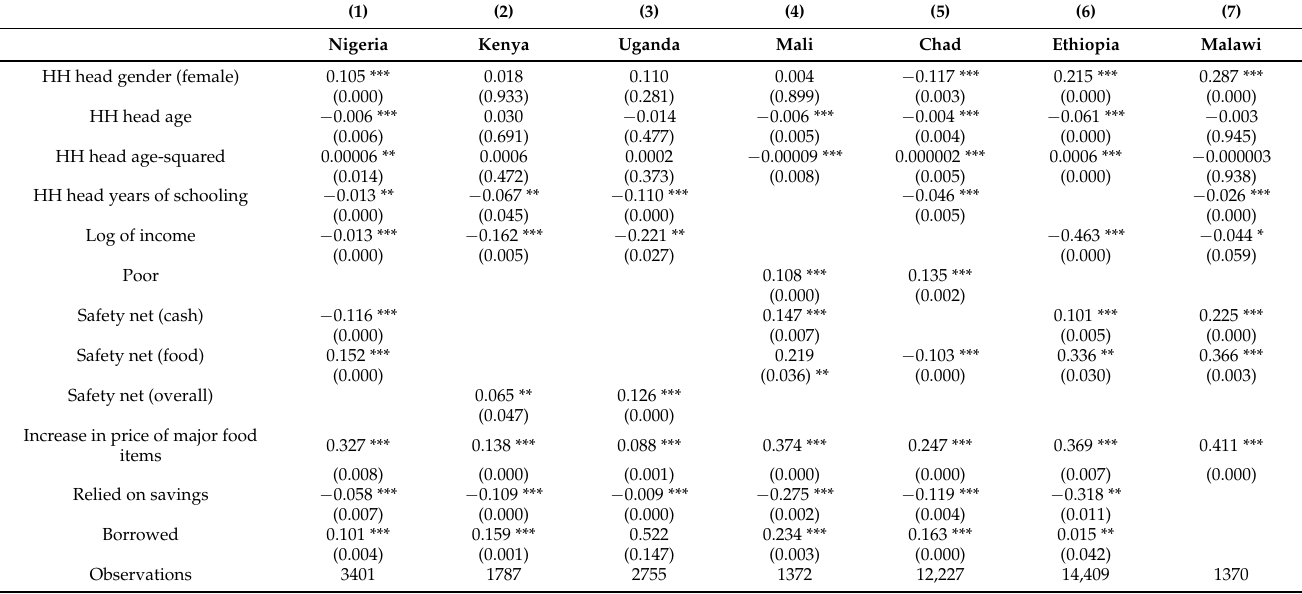
Table A2. Determinants of food insecurity—went without eating for a whole